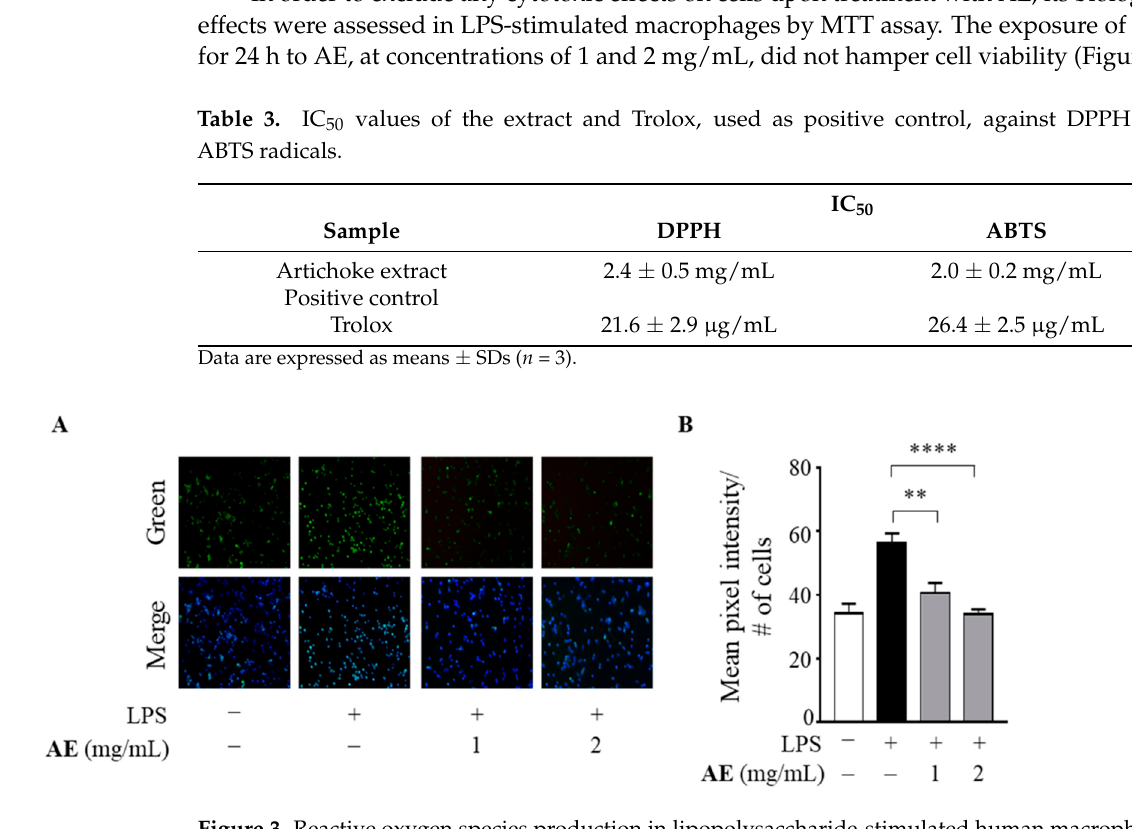
Figure 3. Reactive oxygen species production in lipopolysaccharide-stimulated human macrophages upon treatment with artichoke extract. ( A ) Representative fluorescent microscopy images of reactive oxygen species (ROS) detection in THP-1 macrophages untreated ( − ) or treated with 1 and 2 mg/mL of artichoke extract (AE) for 1 h and then stimulated with 1 µ g/mL of lipopolysaccharides (LPS) for 3 h. Merged fluorescent images of green (CellROX dye) and DAPI (4 ′ ,6-diamidino-2-phenylindole) staining of DNA (blue) are shown. ( B ) Quantitative analysis of ( A ) shown as mean pixel intensity normalized to number of cells (#). Data bars are means ± SEMs of two independent experiments. ** p < 0.005, **** p < 0.0001.